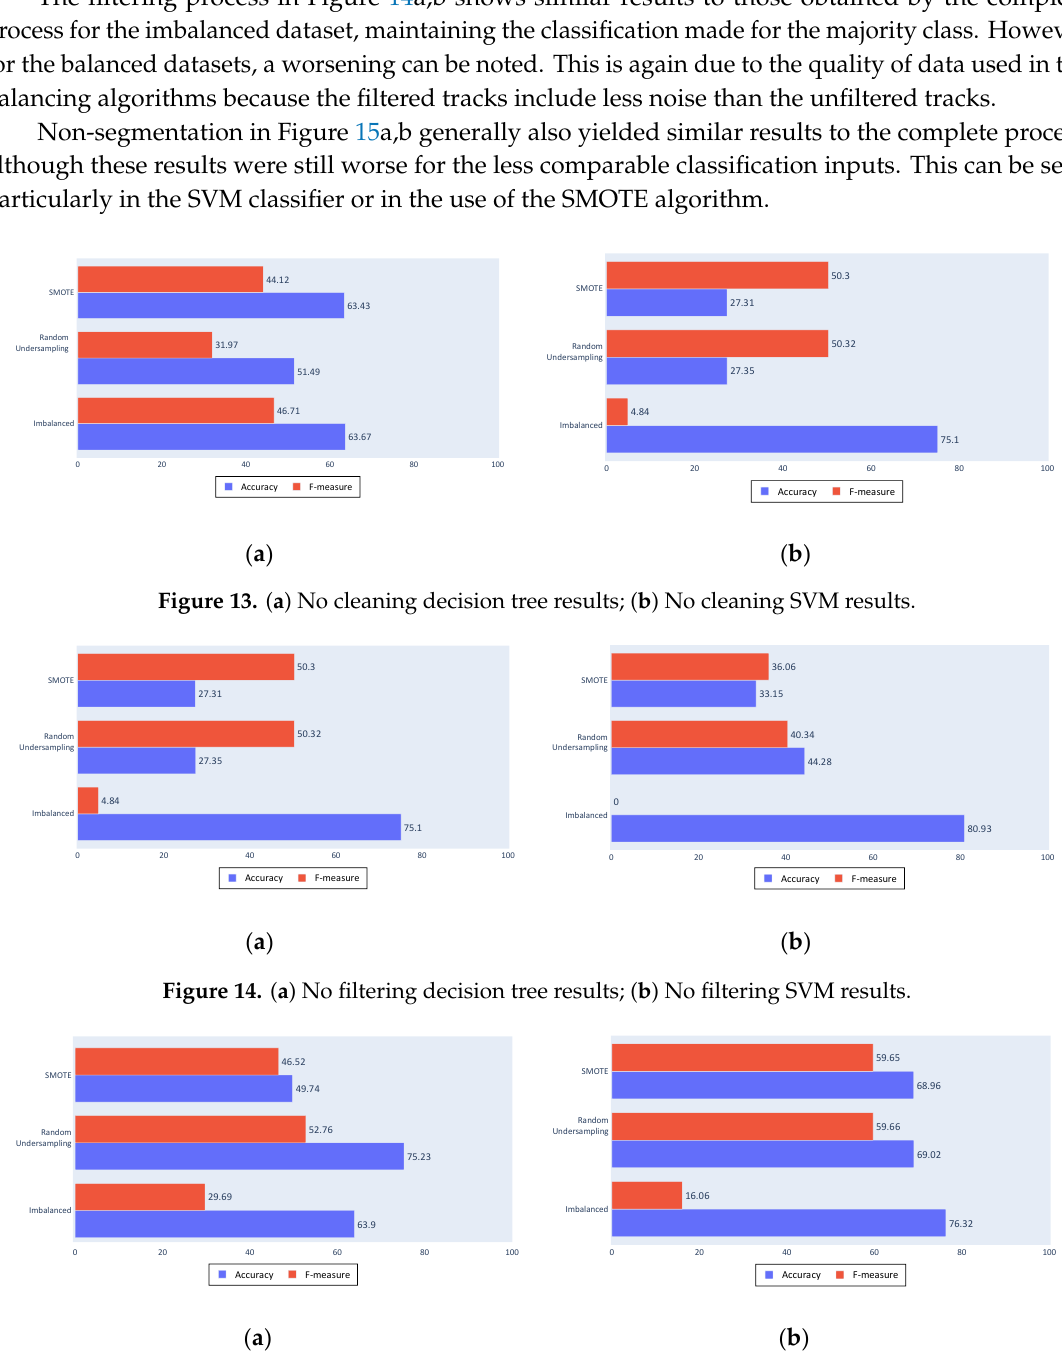
Figure 15. ( a ) No segmentation decision tree results; ( b ) No segmentation SVM results.